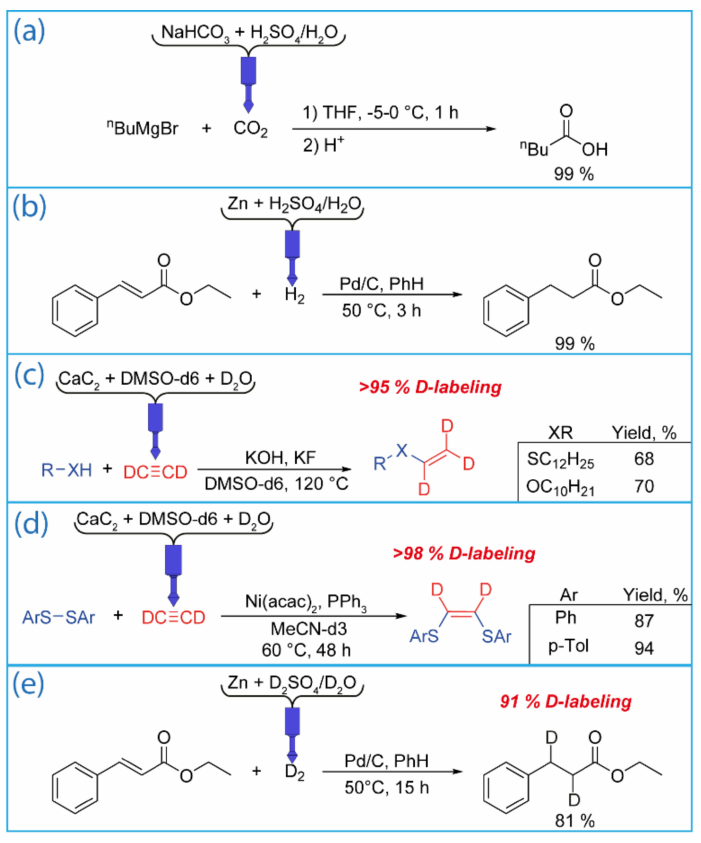
Figure 9. Reactions with gases generated with the use of the designed reactor: ( a ) carboxylation of n-butyl magnesium bromide, ( b ) hydrogenation of ethyl cinnamate, ( c ) nucleophilic addition to C 2 D 2 , ( d ) Ni-catalyzed addition to C 2 D 2 , and ( e ) deuteration of ethyl